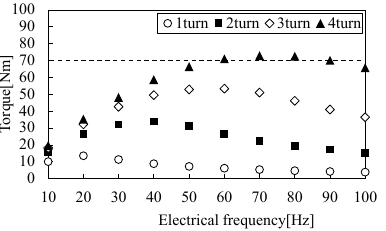
Figure 17. Torque characteristics for number of turns of designed IM.